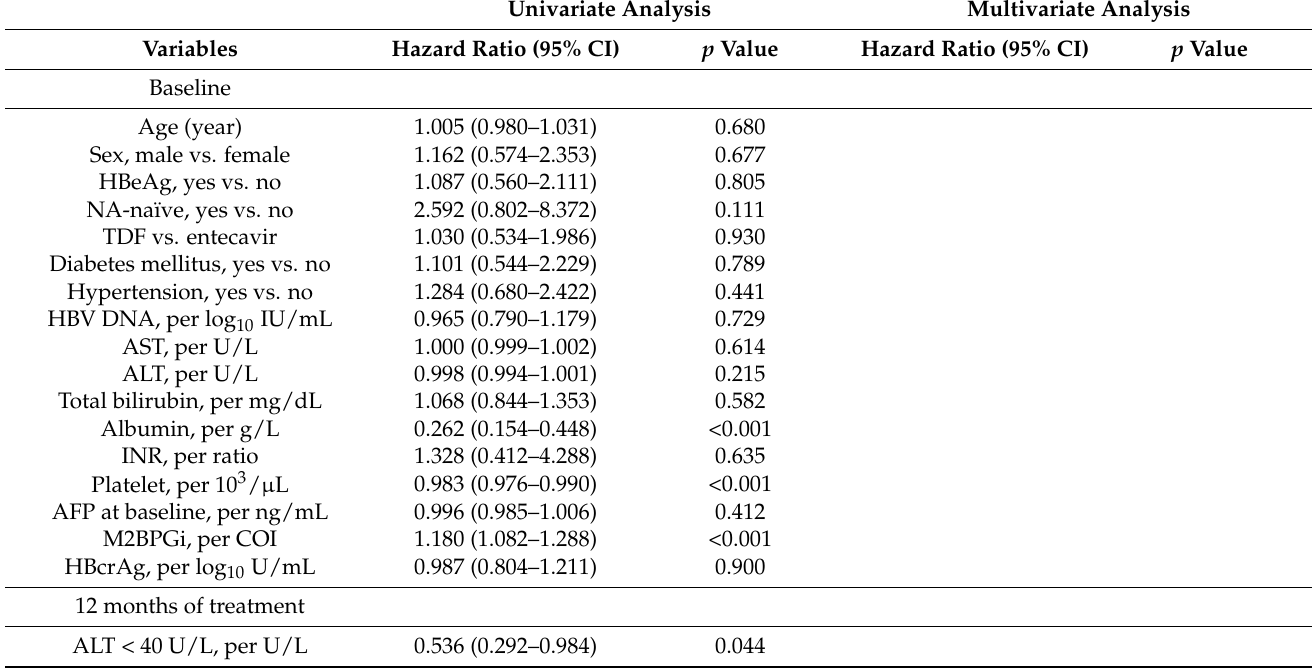
Table 5. Univariate and multivariate analyses of factors associated with hepatic events (new events of variceal bleeding, ascites and hepatic encephalopathy) in patients without decompensated cirrhosis at